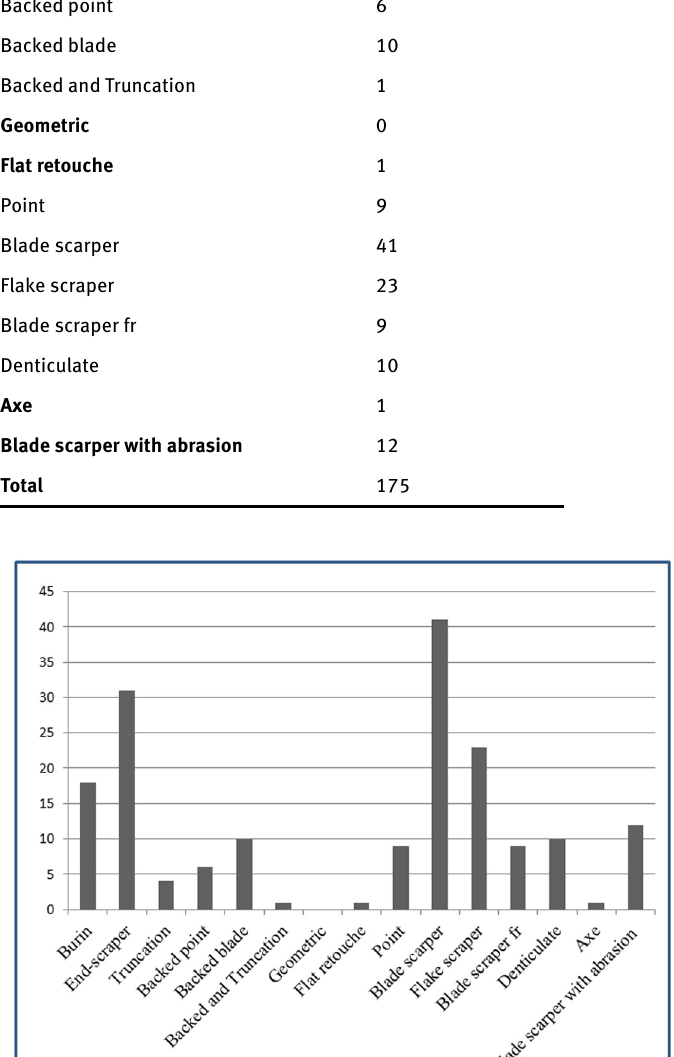
Figure 6. Lipari, Contrada Diana trench XVII. Histogram 4: